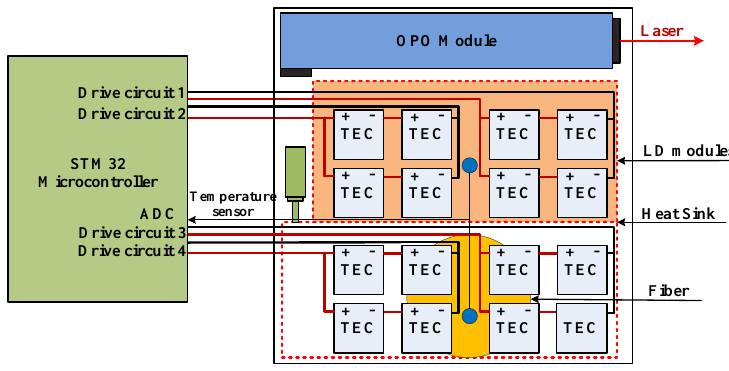
Figure 4. Diagrammatic sketch of the thermoelectric cooler (TEC) layout. Appl. Sci. 2018 , 8 , x FOR PEER REVIEW